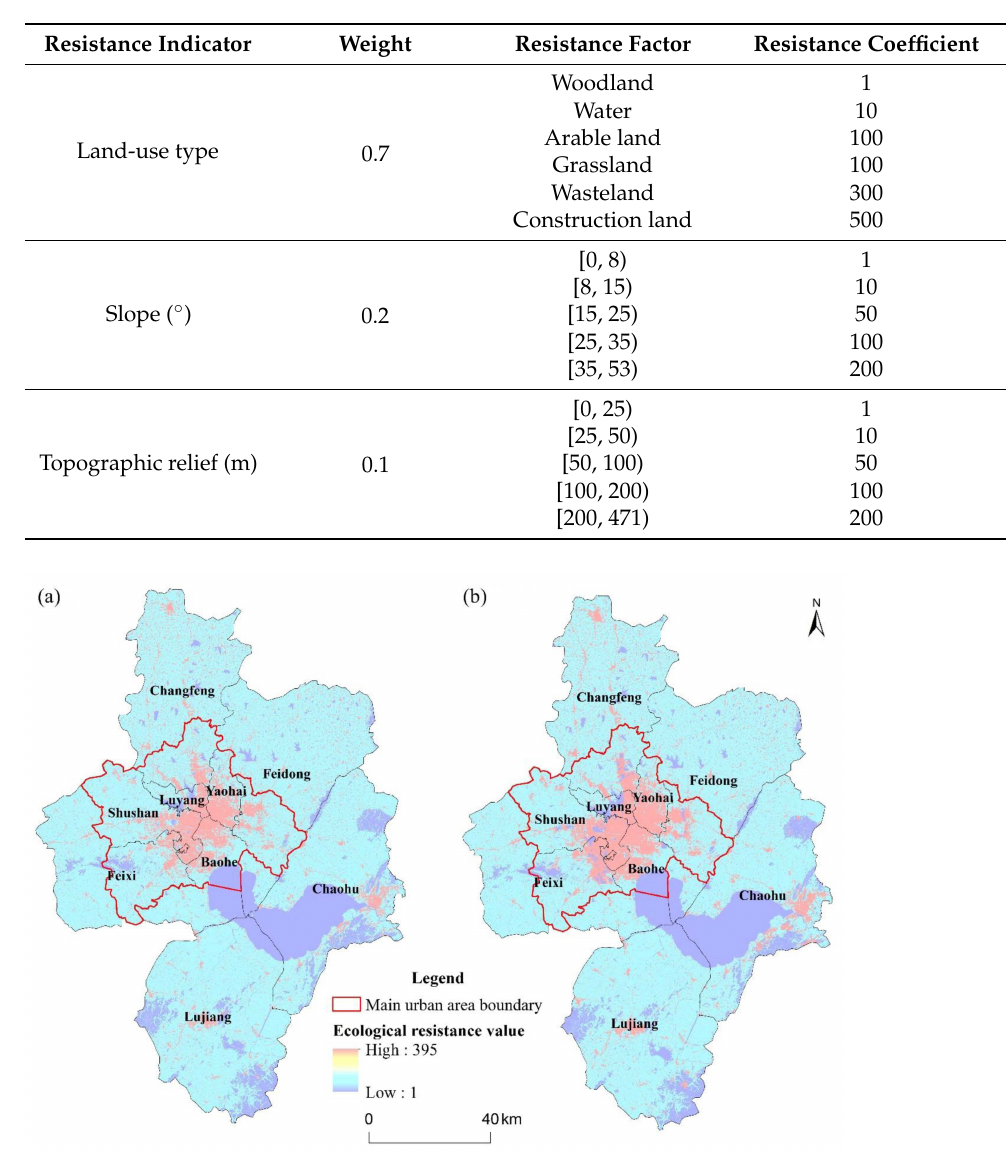
Figure 4. Ecological resistance surface of Hefei for ( a ) 2020 and ( b )